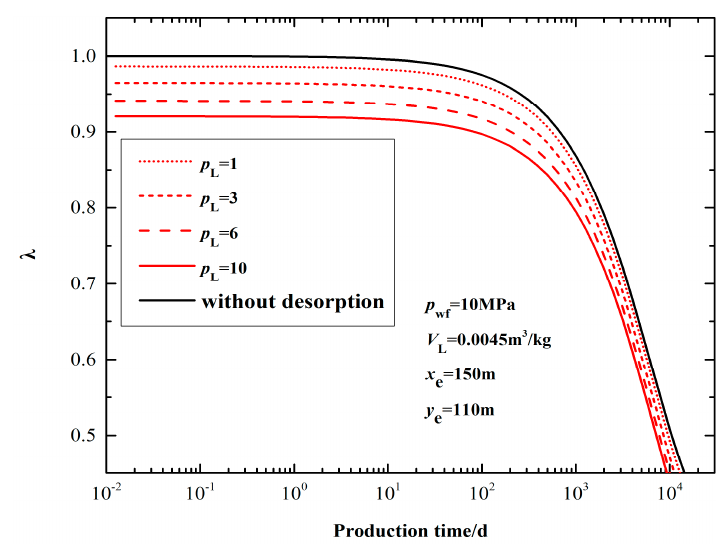
Figure 12. Effects of Langmuir pressure on pseudo-time factor β ( t ).